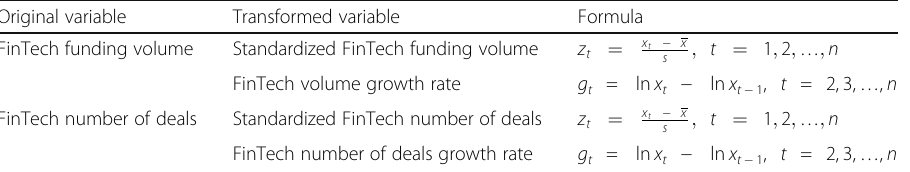
Table 1 Data transformation Original variable Transformed variable Formula FinTech funding